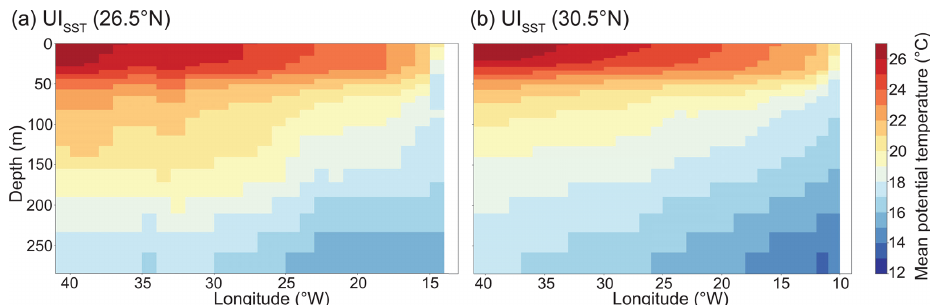
Figure 6. Vertical cross-sections of temperature during upwelling at 26.5 ◦ N (a) and 30.5 ◦ N (b)